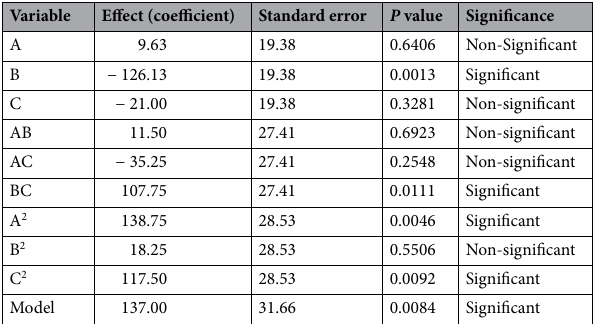
Table 3. Results of ANOVA statistical analysis of tested factors’ effect on size of the produced iron nanoparticles, employing Box-Behnken design. A = Salt conc. “FeSO 4 .7H 2 O”, B = Culture filtrate volume, C = pH.